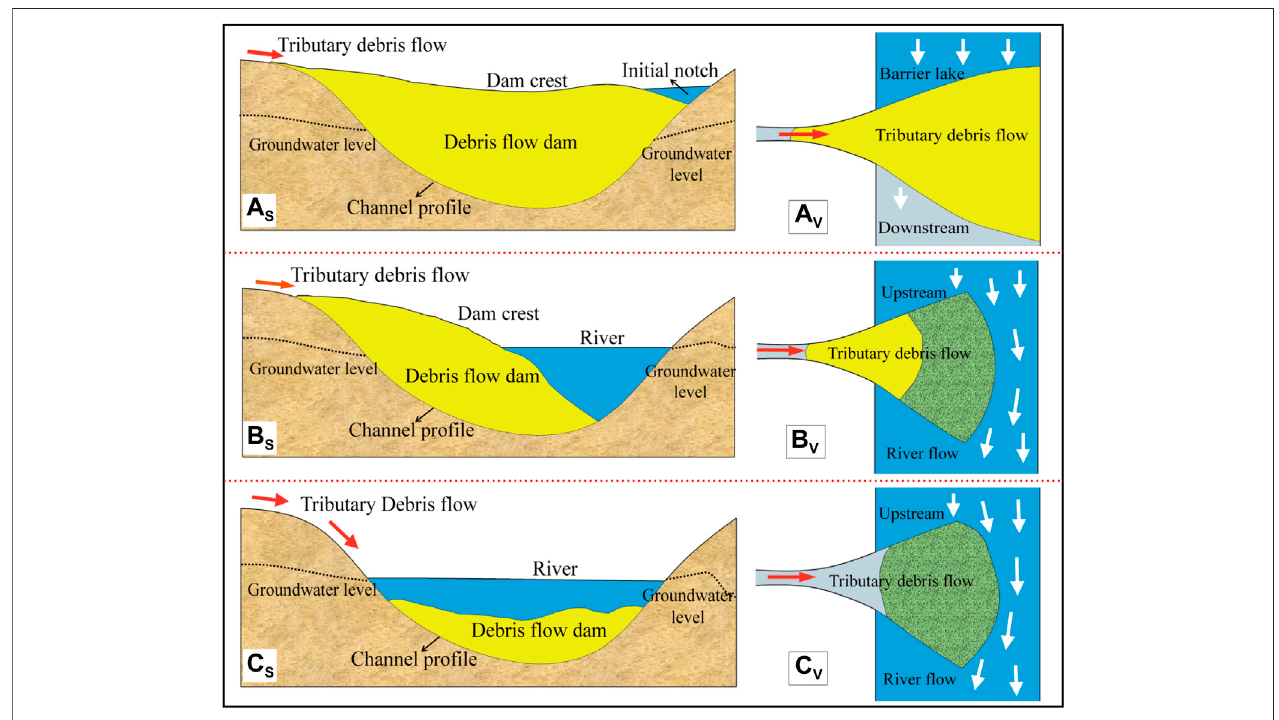
FIGURE 2 | Three river-blocking patterns induced by debris fl ows: (A) Complete blockage, (B) partial blockage, and (C) submerged dam blockage. The subscript “ s ” in the fi gure number represents the “ sectional view ” and “ v ” represents the “ vertical view. ”